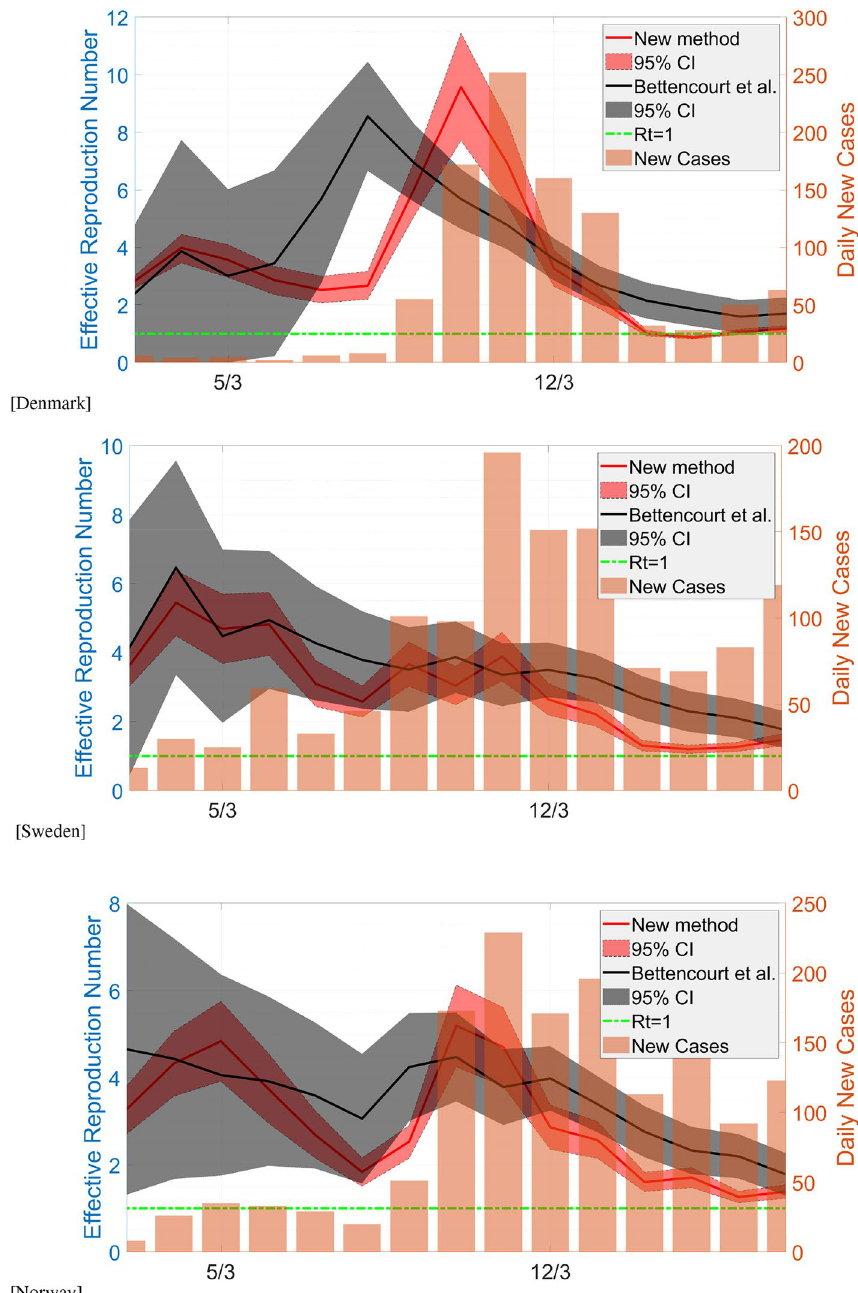
Figure 2. Comparison of the estimated reproduction number at the early stage of the pandemic between our proposed method and Bettencourt and Ribeiro 11 .